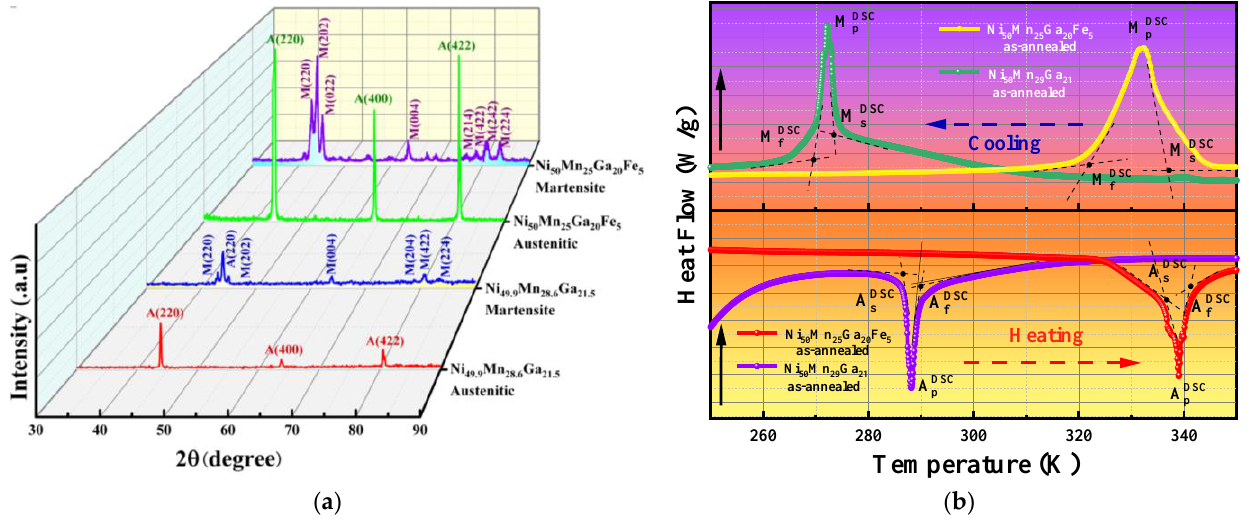
Figure 3. ( a ) XRD diagram of polycrystalline alloy microwire, ( b ) DSC diagram of polycrystalline alloy microwire.